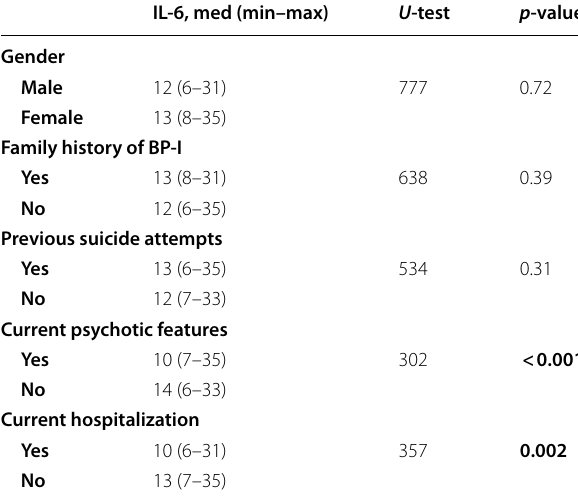
Table 3 Comparison of serum IL-6 levels according to the